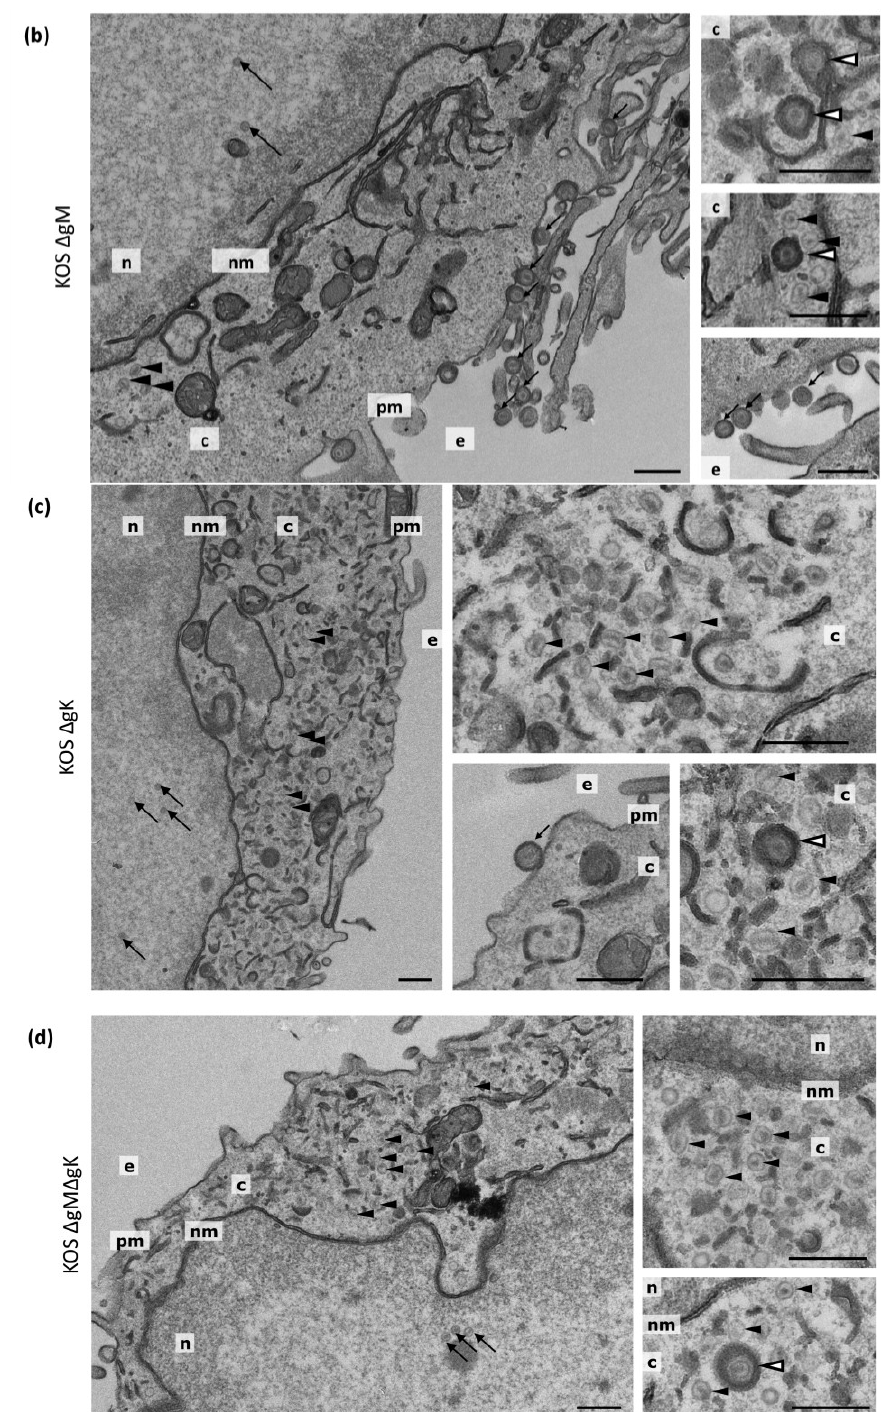
Figure 5. Ultrastructural morphology of cells infected with KOS WT, ∆gM, ∆gK and ∆gM∆gK viruses. HaCaT cells were infected with ( a ) KOS WT; ( b ) ∆gM; ( c ) ∆gK; and ( d ) ∆gM∆gK virus at an MOI of 5 PFU/cell and processed for electron microscopy at 20 hpi. Representative nuclear capsids are marked with large black arrows, extracellular virions with small black arrows, cytoplasmic enveloped virions with white arrowheads and cytoplasmic naked capsids with black arrowheads. The nucleus (n), cytoplasm (c), nuclear membrane (nm) plasma membrane (pm) and extracellular space (e) are marked. Scale bars: 500